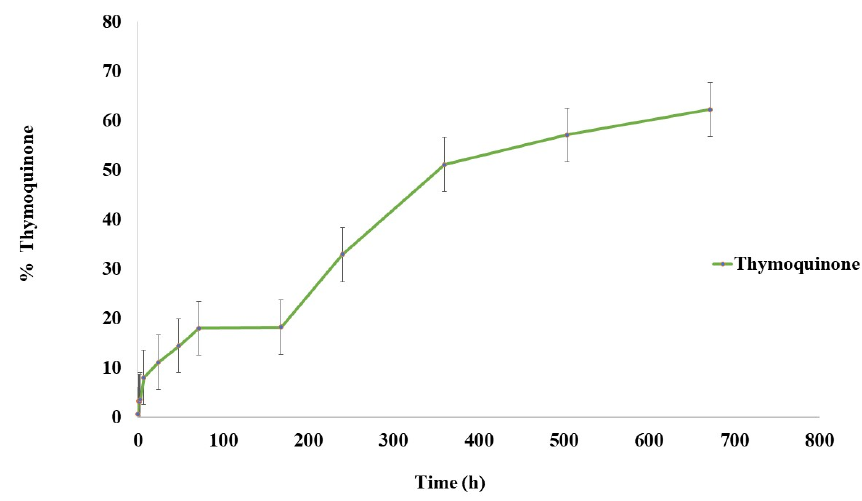
Figure 2. In vitro drug release of NPCH-TQ in PBS at pH 6.